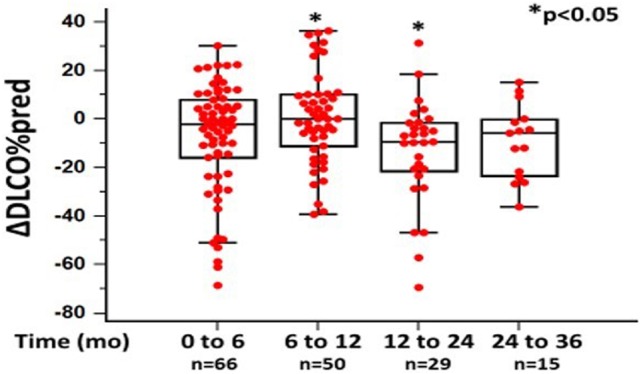
Changes in %diffusion capacity of lung for carbon monoxide (ΔDLCO) as %predicted ± SD, at different time points following pirfenidone treatment. Time 0 denotes the onset of treatment. Deaths were treated as censored. One-way ANOVA, p < 0.05.